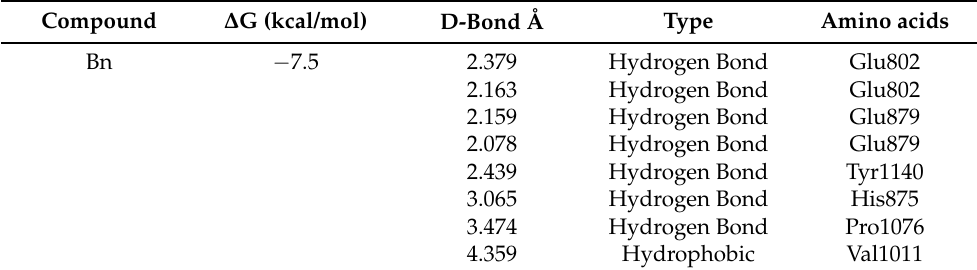
Table 4. Docking results of binding of Bn to active site of xanthine oxidase.